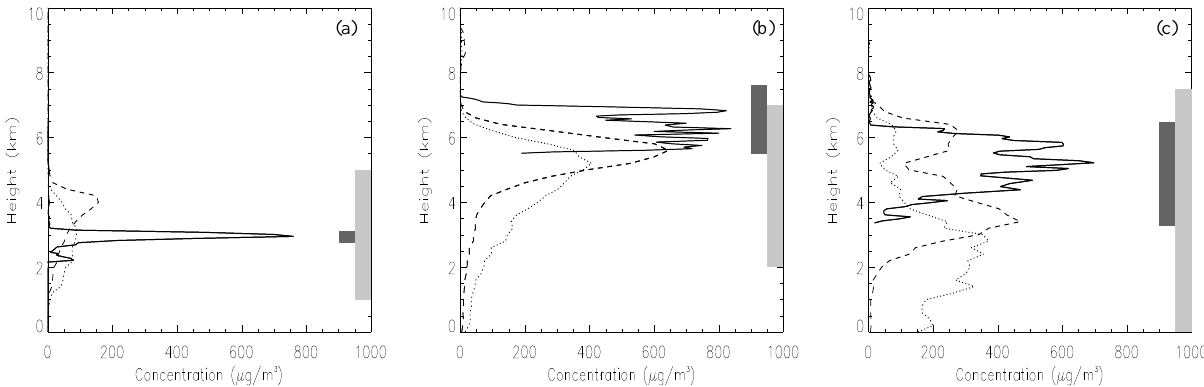
Fig. 3. Concentration profiles for (a) 12:00UTC on 5 May, (b) 13:00UTC on 14 May and (c) 15:00UTC on 17 May. Observations (solid) and NAME simulations using distal particle size distribution 1 (dotted) and 2 (dashed). The dark grey bar shows the height range over which the observed particle size distributions are calculated. The light grey bar shows the height range over which the NAME simulated particle size distributions are calculated.